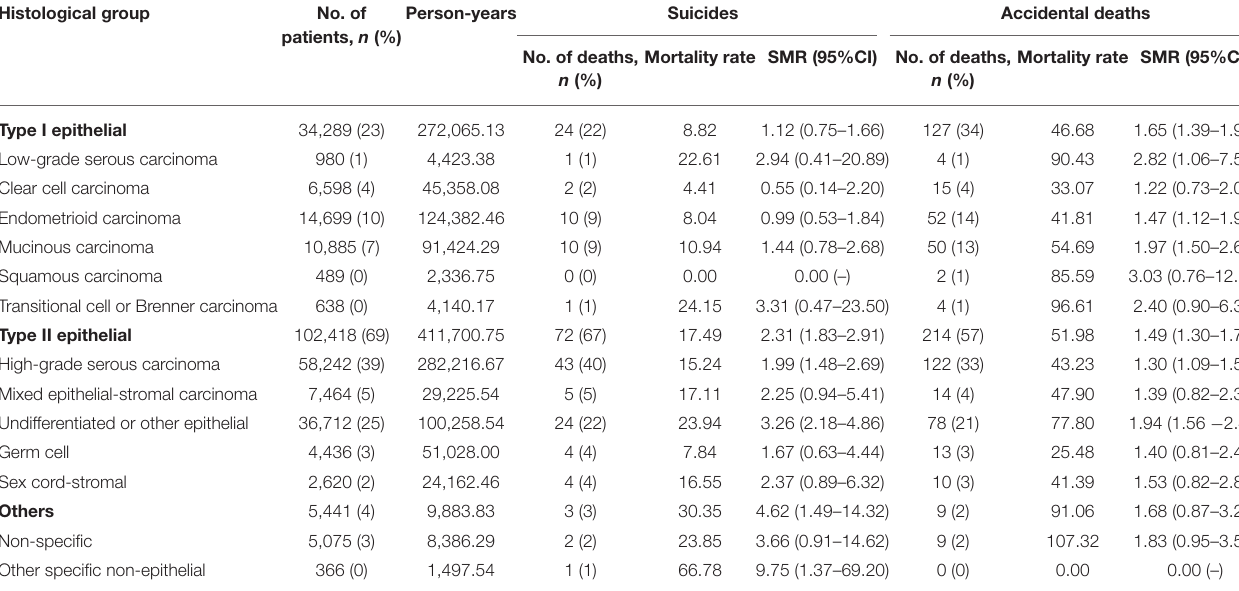
TABLE 3 | The risk of suicide and accidental death among patients with ovarian cancer by histological subgroup. Histological